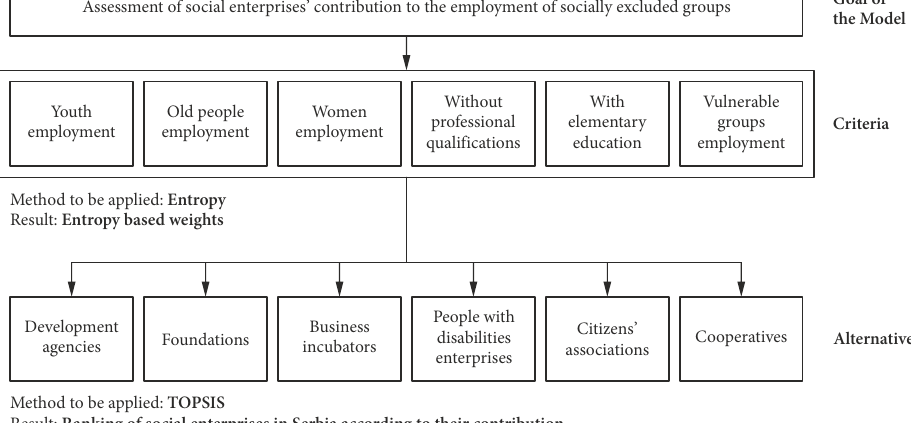
Figure 2. MCDM Model Flowchart – Integrated Approach of Entropy and TOPSIS